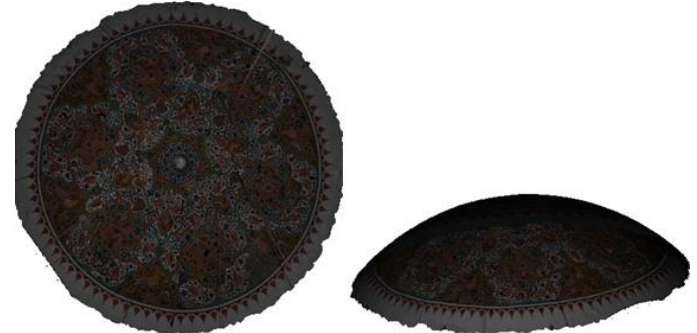
Figure 13. Orthophoto and texture mapped 3-D model of the dome of Semahane. ISPRS Int. J. Geo-Inf. 2016 , 5 , 18